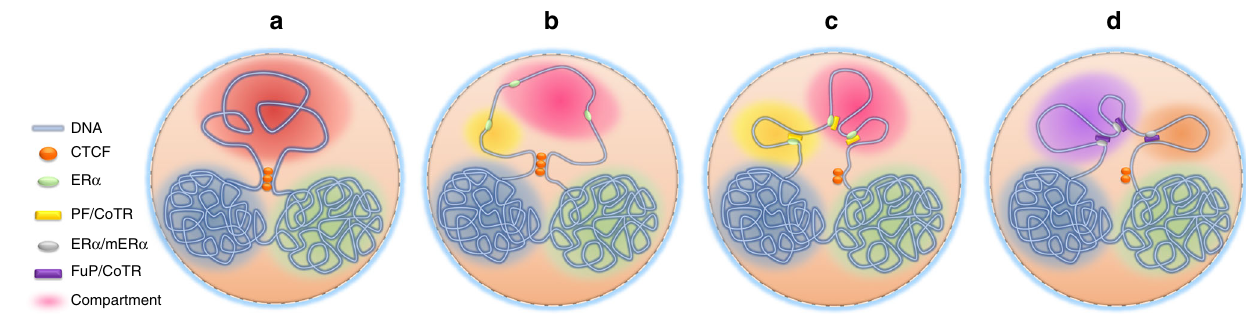
Fig. 7 A proposed model for dynamic 3D chromatin architecture. a − c Constitutive estrogen stimulation in breast cancer cells enhances stronger ER α activity and further recruits its distal regulatory machinery and then mobilizes highly dynamic gene looping which essentially expand to render a 3D genome re-compartmentalization accompanying with lower CTCF binding at the compartment boundary. d . In acquired resistant breast cancer cells, increased crosstalk between ER α and other signal transduction pathways such as EGFR/HER2, IGF-IR, and AKT/PTEN or altered expression of some key coregulators particularly reshuf fl e these highly dynamic gene looping resulting in altered chromatin reorganization. CTCF CCCTC-binding